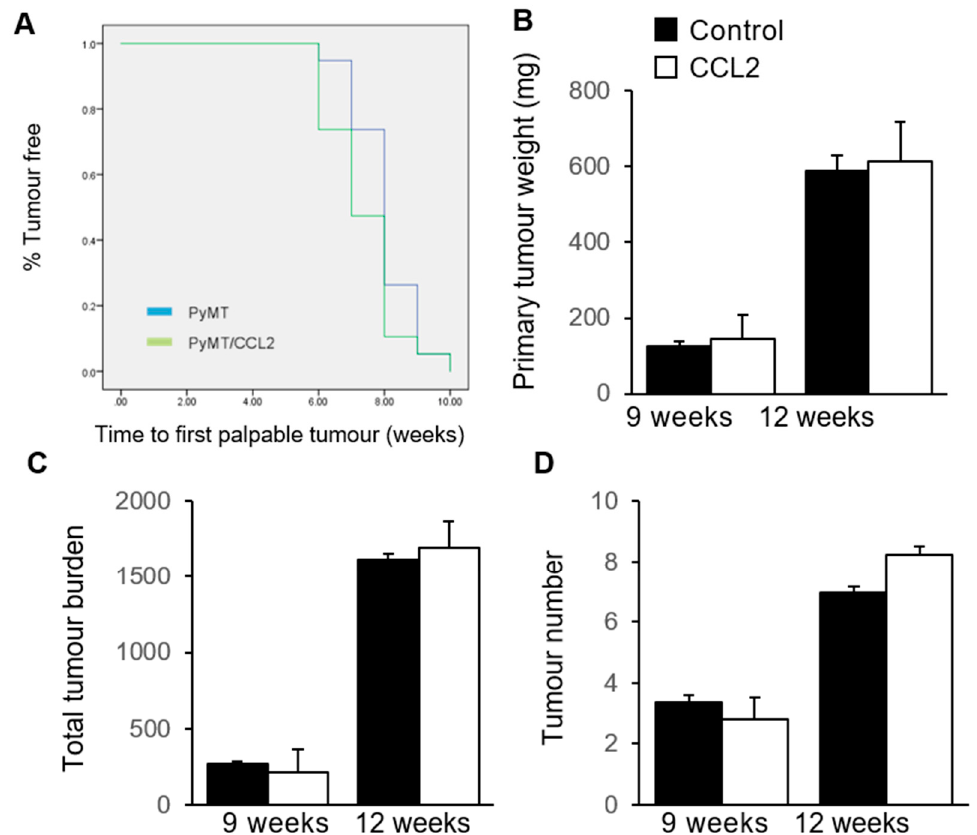
Figure 4. The effect of CCL2 overexpression on tumour development in PyMT transgenic mice. PyMT and PyMT/CCL2 mice were palpated weekly to monitor tumour latency from 6 weeks of age ( n = 28 per group). ( A ) Kaplan–Meier survival plot of the percentage of tumour free mice for each week of monitoring. Primary and secondary tumours were collected at 9 ( n = 9 per group) and 12 weeks of age ( n = 10 per group). ( B ) Primary tumour weight, ( C ) total tumour burden (mg), and ( D ) number of tumours were measured in each mouse. Data presented as mean + SEM. Statistical analysis performed using SPSS, mean survival was tested using Log Rank test.